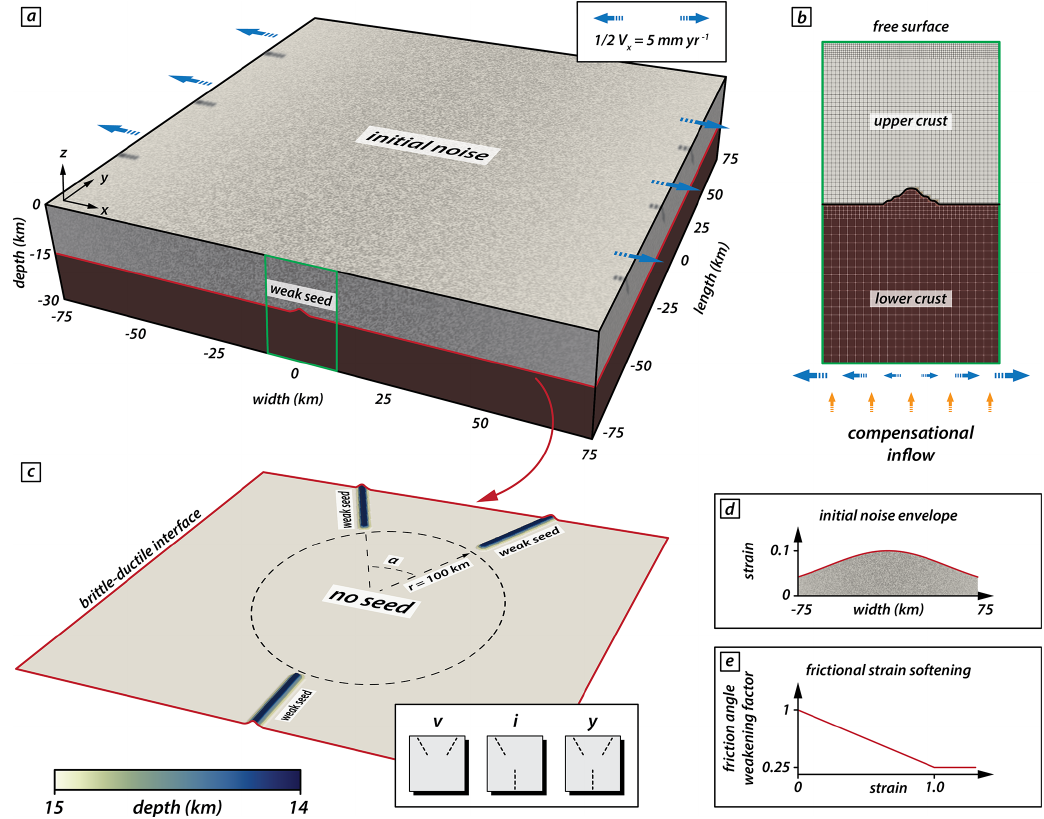
Figure 4. Numerical model setup for isoviscous models. (a) The model domain comprises a volume of 150 × 150 × 30km. Blue arrows indicate the applied boundary-orthogonal extension. The green rectangle indicates the position of the zoom-in in panel (b) . The red line indicates the initial depth of the brittle–ductile interface (as defined by the interface between the two rheological layers) indicated in (c) . (b) Initial conditions and mesh refinement (arrows not to scale). (c) Position and configuration of the mechanical weak seeds at the brittle– ductile interface. The setup comprises an area with radius r = 100km wherein no weak seeds are present. Three different seed configurations refer to y , i , and v models (see text for details). Color map from Crameri et al. (2020). (d) Initial amplitude of strain along the x axis. The Gaussian distribution is constant along the y axis; also see the grey shading in (a) . Note that while the strain amplitude follows a Gaussian distribution, the location of the initial strain is random. (e) Linear weakening with strain applied to the friction